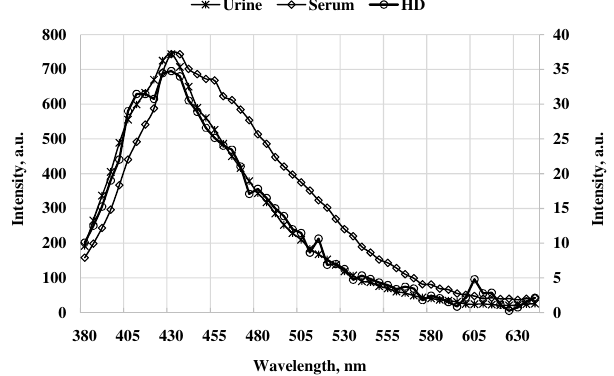
Fig. 1. A CKD Pt's bio°uids °uorescence spectra measured at (cid:1) ¼ 360 nm. Serum and urine spectra are normalized at exc 435 nm. For HD spectrum the right-hand axis is valid.